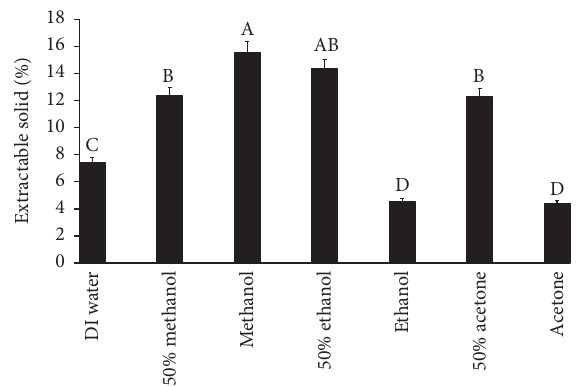
Figure 1: Effect of solvents on extractable solids from the root of S. chinensis . The values are the mean average of three replications for each solvent ± standard deviation. Columns not sharing the same superscript letter are significantly different 𝑝 < 0.05 (DI water: deionized